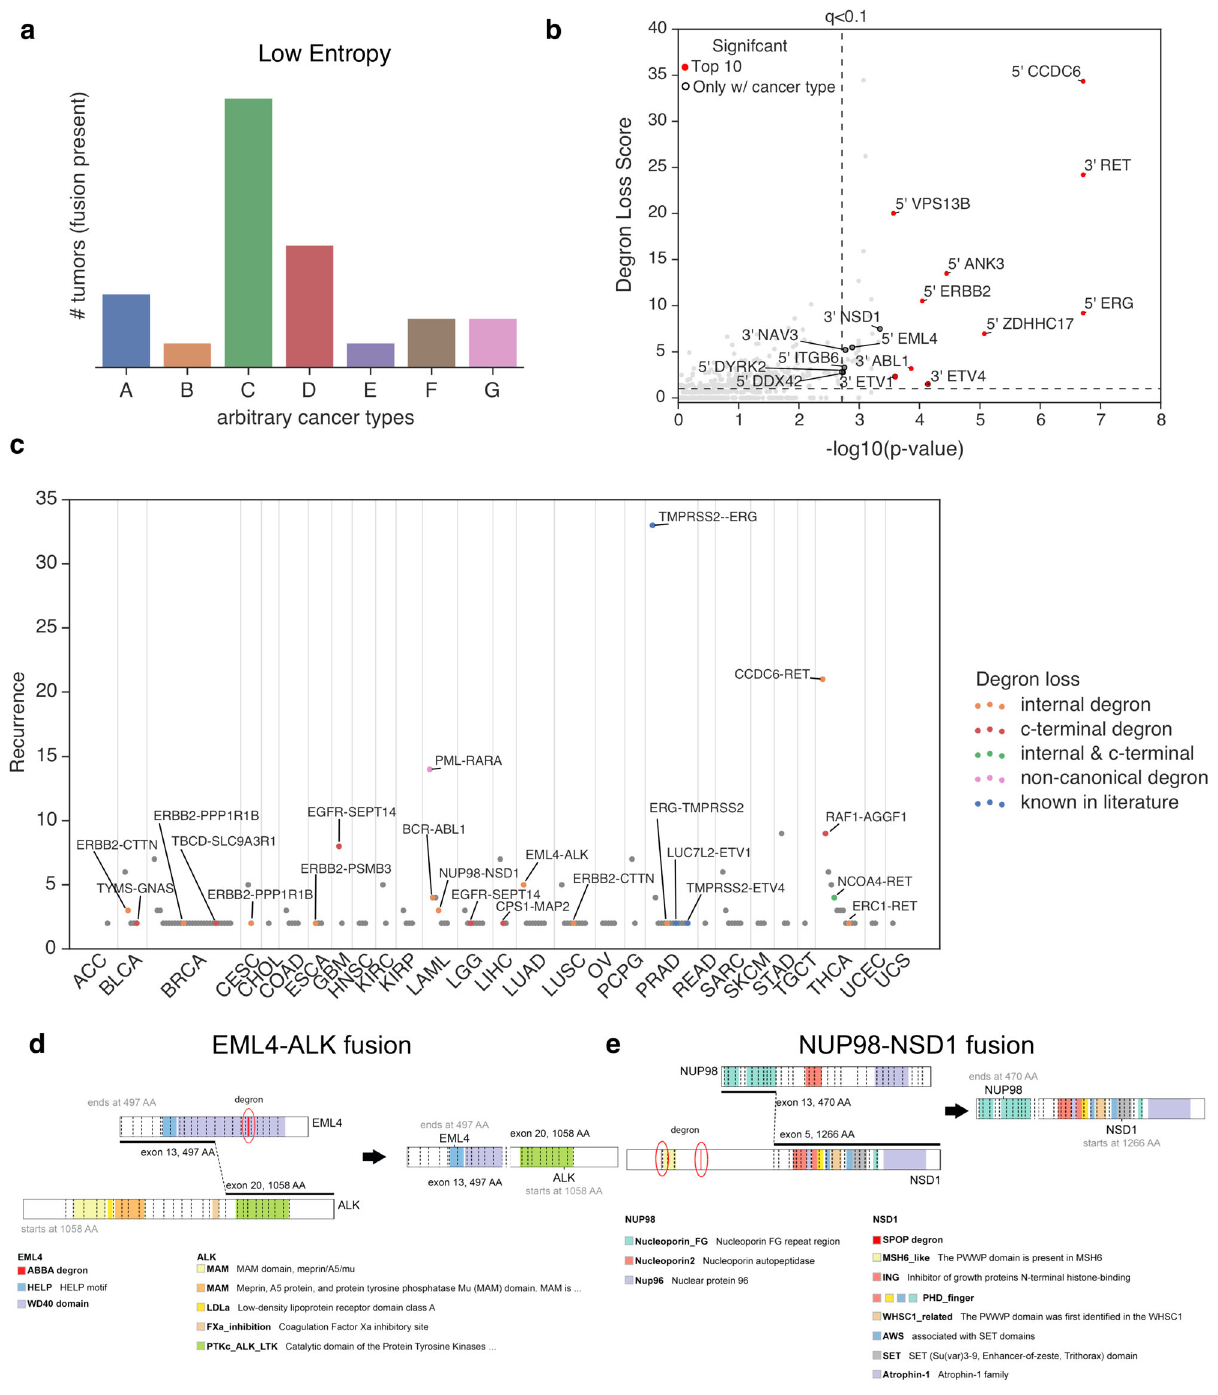
Fig. 3 Cancer type-speci fi city of genetic fusions reveals oncogenicity. a Conceptual diagram showing that a low entropy value that summarizes the distribution of a fusion across cancer types indicates the fusion gene is cancer type-speci fi c. b Scatter plot showing the statistical signi fi cance of gene fusions for loss of internal degrons when also considering information on cancer type-speci fi city. X -axis represents the combined p value for both degron loss and cancer type-speci fi city (Fisher ’ s method), while the Y -axis represents the effect size for degron loss. P values were calculated using a one-sided permutation test. See “ Methods ” for additional details on calculation of p values. c Scatter plot indicating the most recurrent fusion genes for particular cancer types. Fusion genes with degron loss are labeled in color, including internal degrons, C-terminal degrons, and those degrons previously known in the literature. d A schematic diagram showing the fusion of EML4 and ALK genes in lung adenocarcinoma. e A schematic diagram showing the fusion of NUP98 and NSD1 genes in lung adenocarcinoma. The relevant raw data are provided in Source Data.